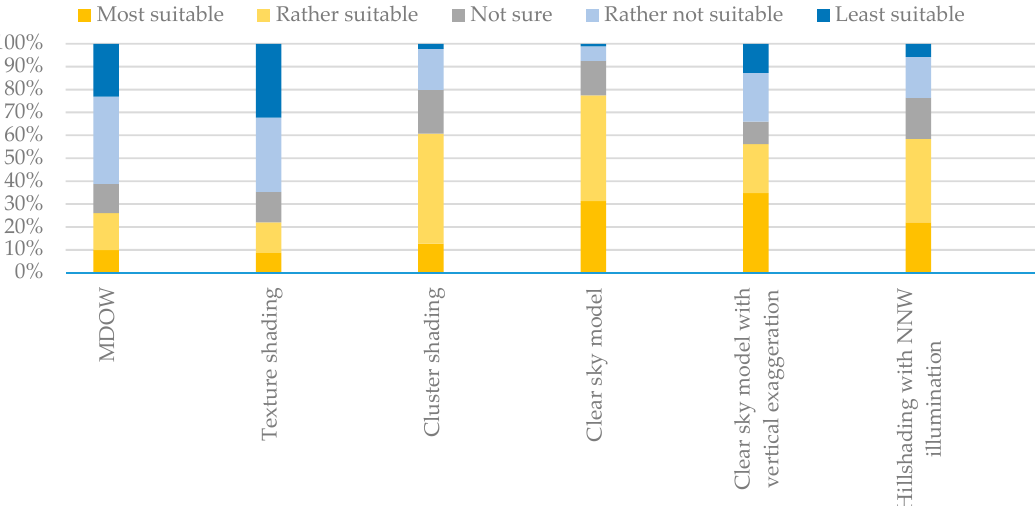
Figure 8. Survey results for folded